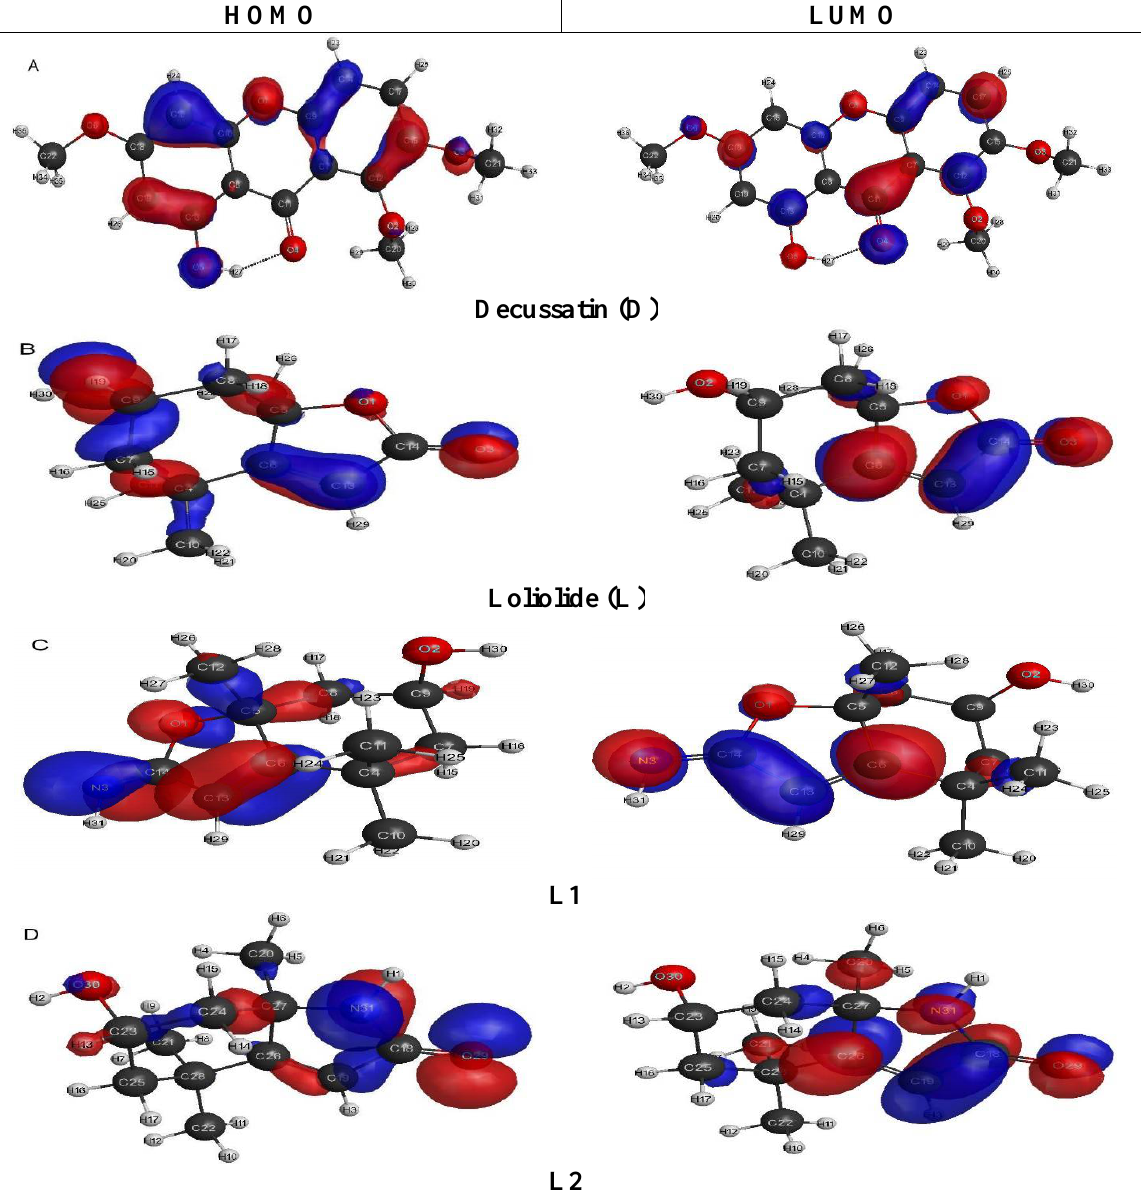
Figure S1: The color-coded contour maps illustrating the Highest occupied molecular orbitals(HOMO) and the lowest unoccupied molecular orbital (LUMO) of the entire ligand